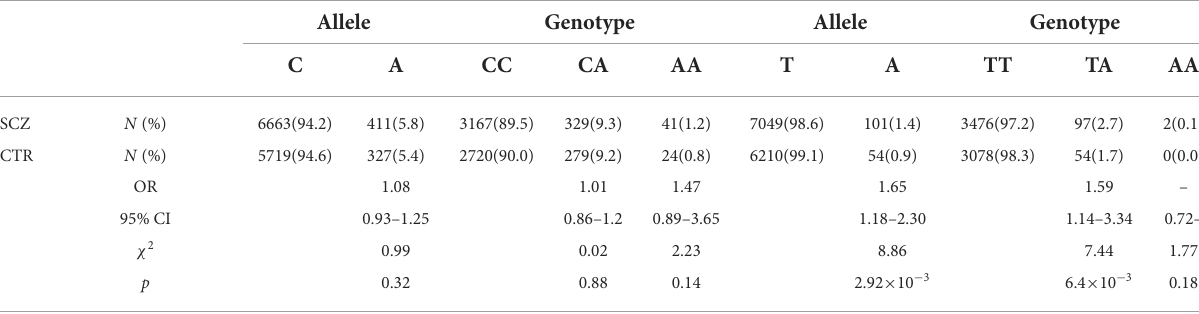
TABLE 5 Association of two SNPs of interest with